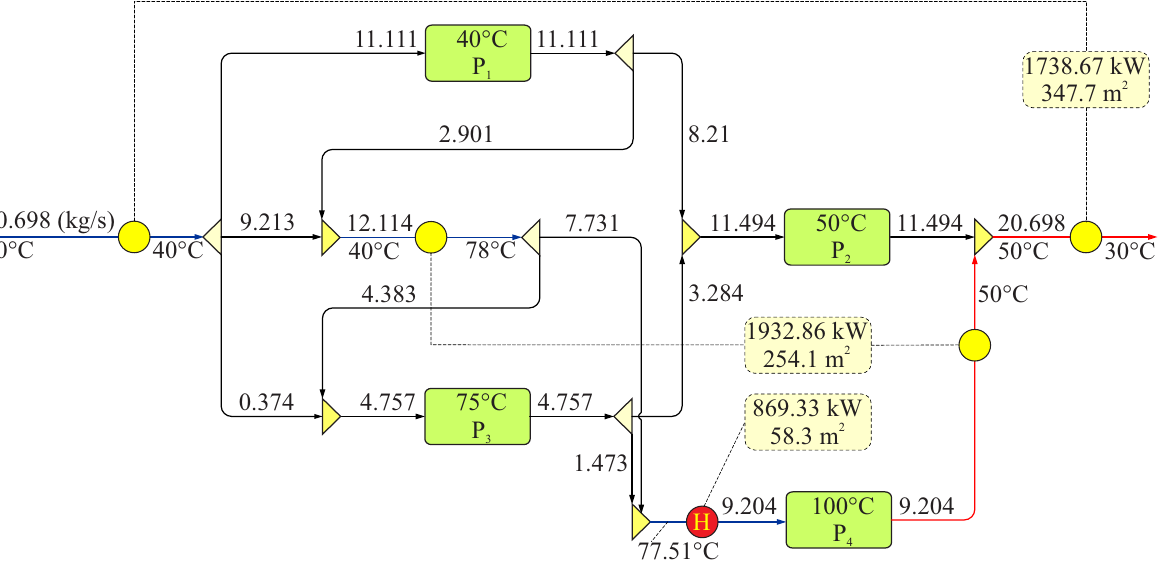
Figure 11. Optimal network design for Example